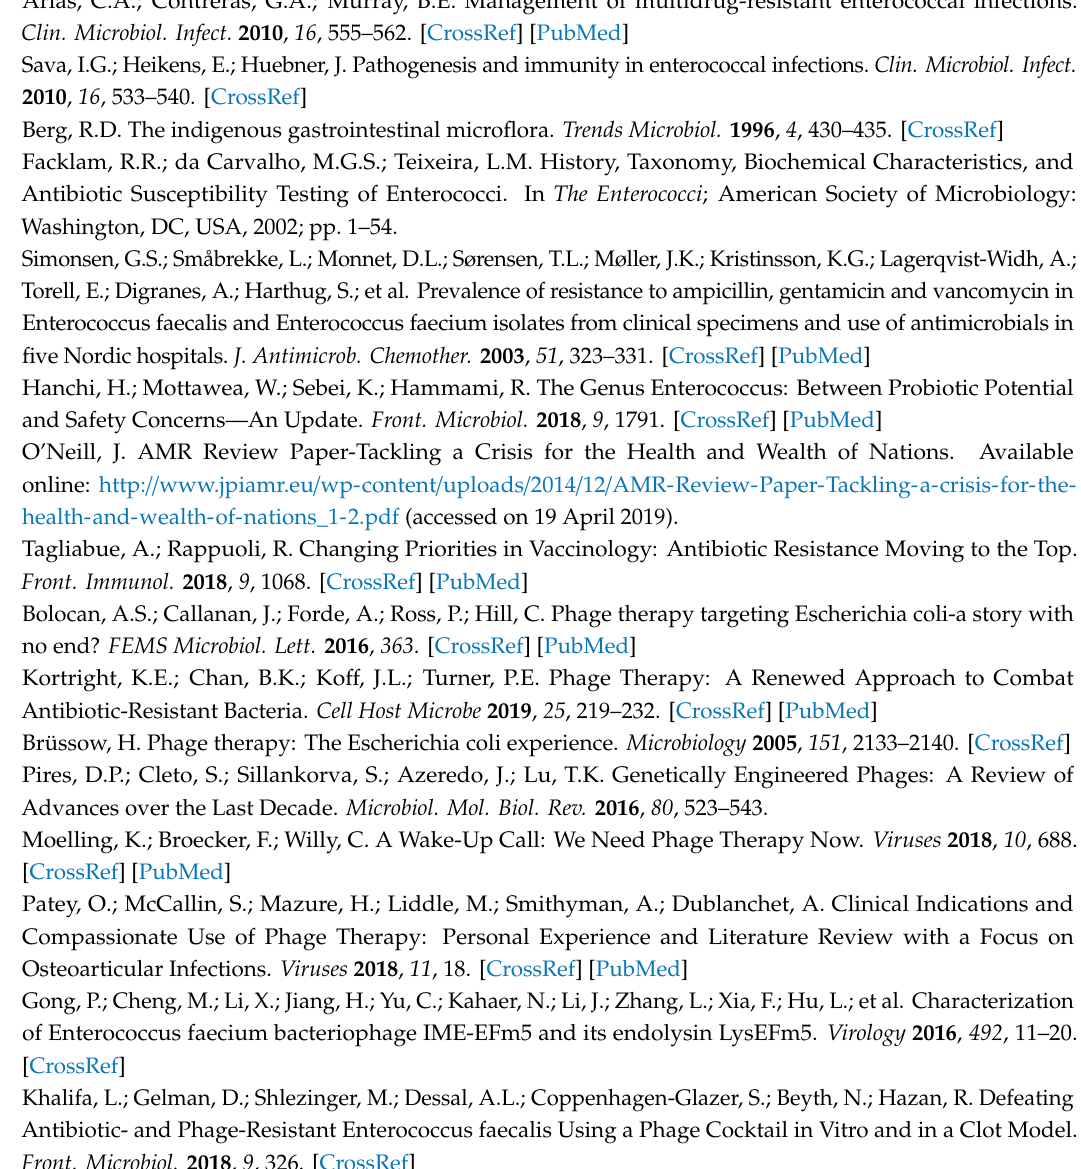
Table S1: E. faecalis phages selected for the OrthoMCL